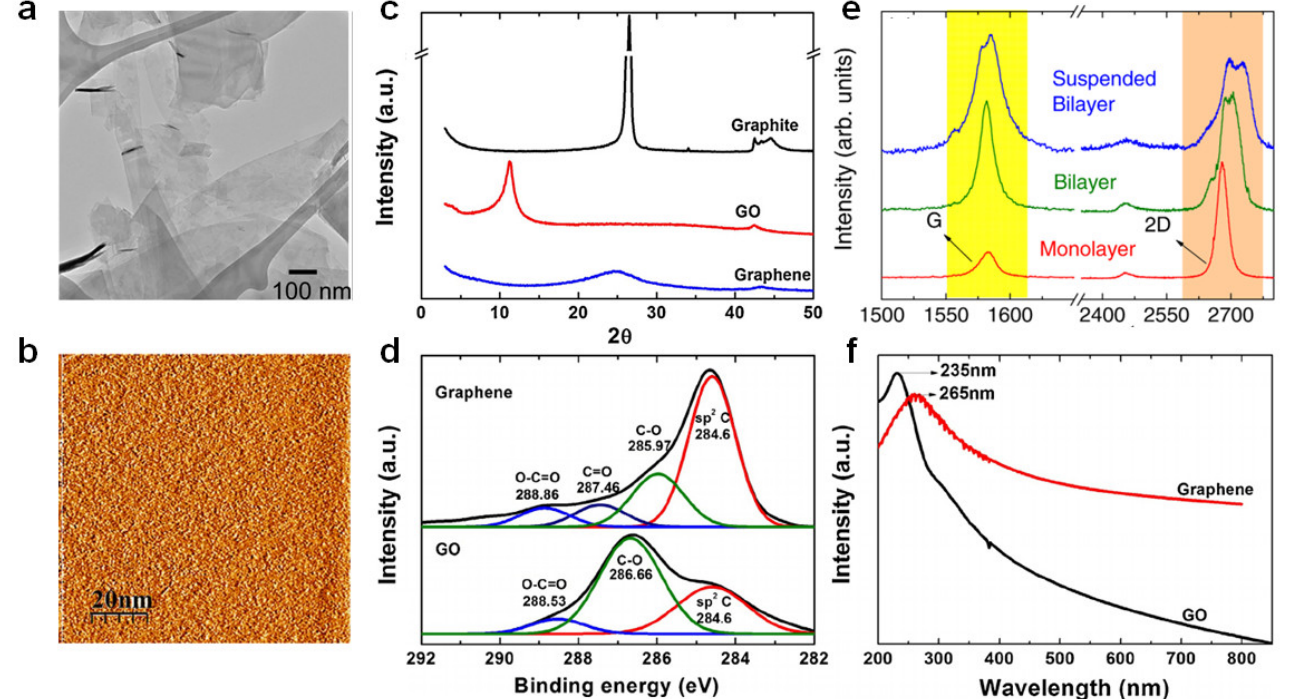
Figure 3. ( a ) Flakes of few-layer graphene on a holey carbon TEM grid. Adapted with permission from Ref. [51]. ( b ) STM images of graphene. Reprinted with permission from Ref. [47]. Copyright 2012 Hong et al. ( c ) XRD patterns of graphite, graphene oxide and graphene. Adapted with permission from Ref. [50]. Copyright 2014 Johra and Lee. ( d ) XPS spectra of GO and graphene [50]. ( e ) Raman spectra of monolayer, bilayer, and suspended bilayer graphene. Adapted with permission from Ref. [52]. Copyright 2011 AIP Publishing. ( f ) UV–vis spectra of GO and graphene. Adapted with permission from Ref. [50]. Copyright 2014